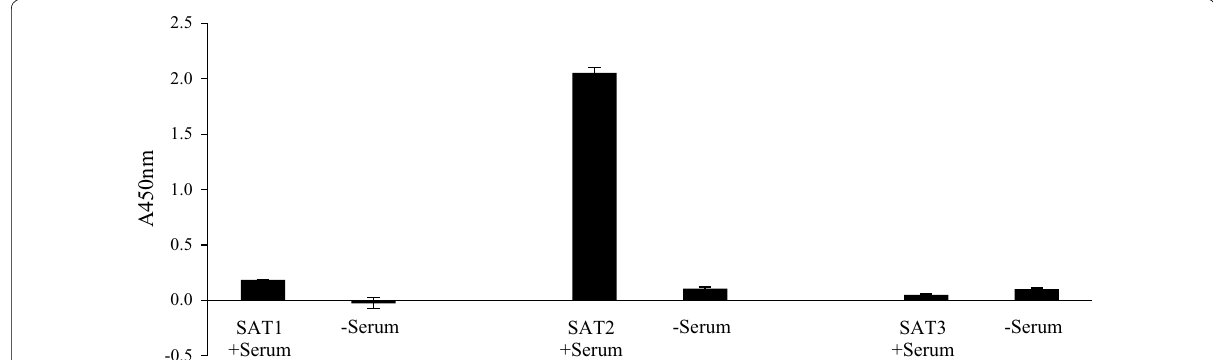
Fig. 5 A graph illustrating the antigenicity and specificity of the recombinant VP1 as measured in a direct ELISA where the expressed VP1 protein was immobilized, then incubated in octuplicate with sera from guinea pigs that were immunized with FMDV SAT1, 2 and 3 viruses, respectively. Serum of naïve guinea pigs were included as controls (error bars represent the standard